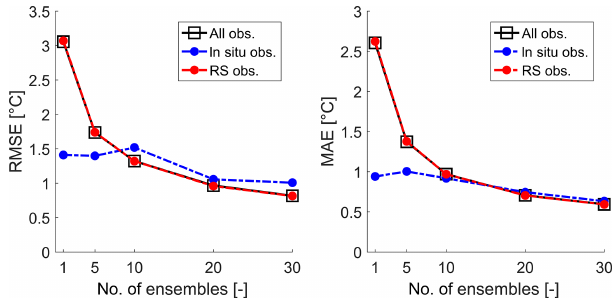
Figure 8. Data assimilation performance as a function of ensemble size. The dashed blue line corresponds to the error with respect to in situ observations only; the red line is the same with respect to LSWT only, and the black squares show the model error with respect to both observation